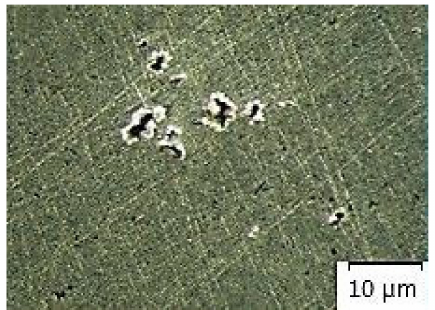
Figure 9. Microscopic evaluation of sample 3/ × 100/.